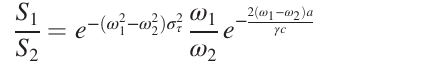
FIG. 8. Beam position signal reconstructed using CChDR, compared to simulations. Experimental points obtained averaging over 10 pulses, each containing 10 electron